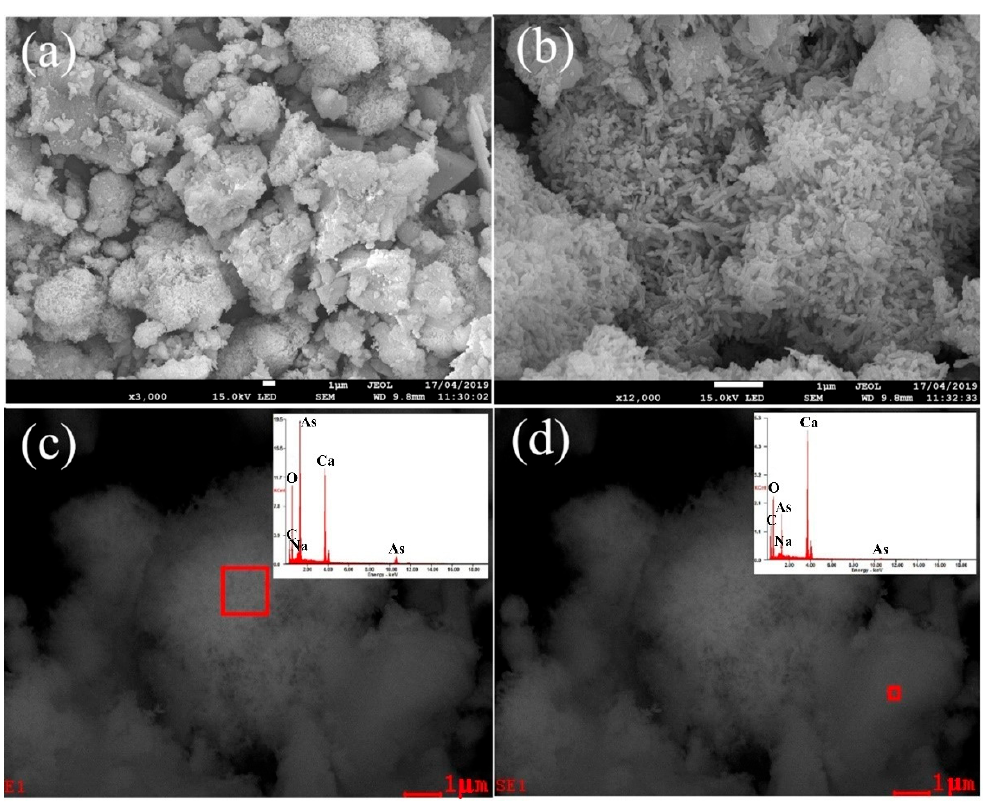
Figure 9. XRD pattern of the precipitate from the causticization process in vacuum.